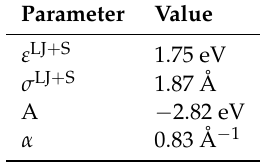
Table 1. Table listing the parameters for the ferromagnetic (FM) parameterisation of the LJ + S potential. Parameter Value ε LJ + S 1.75 eV σ LJ + S 1.87 Å